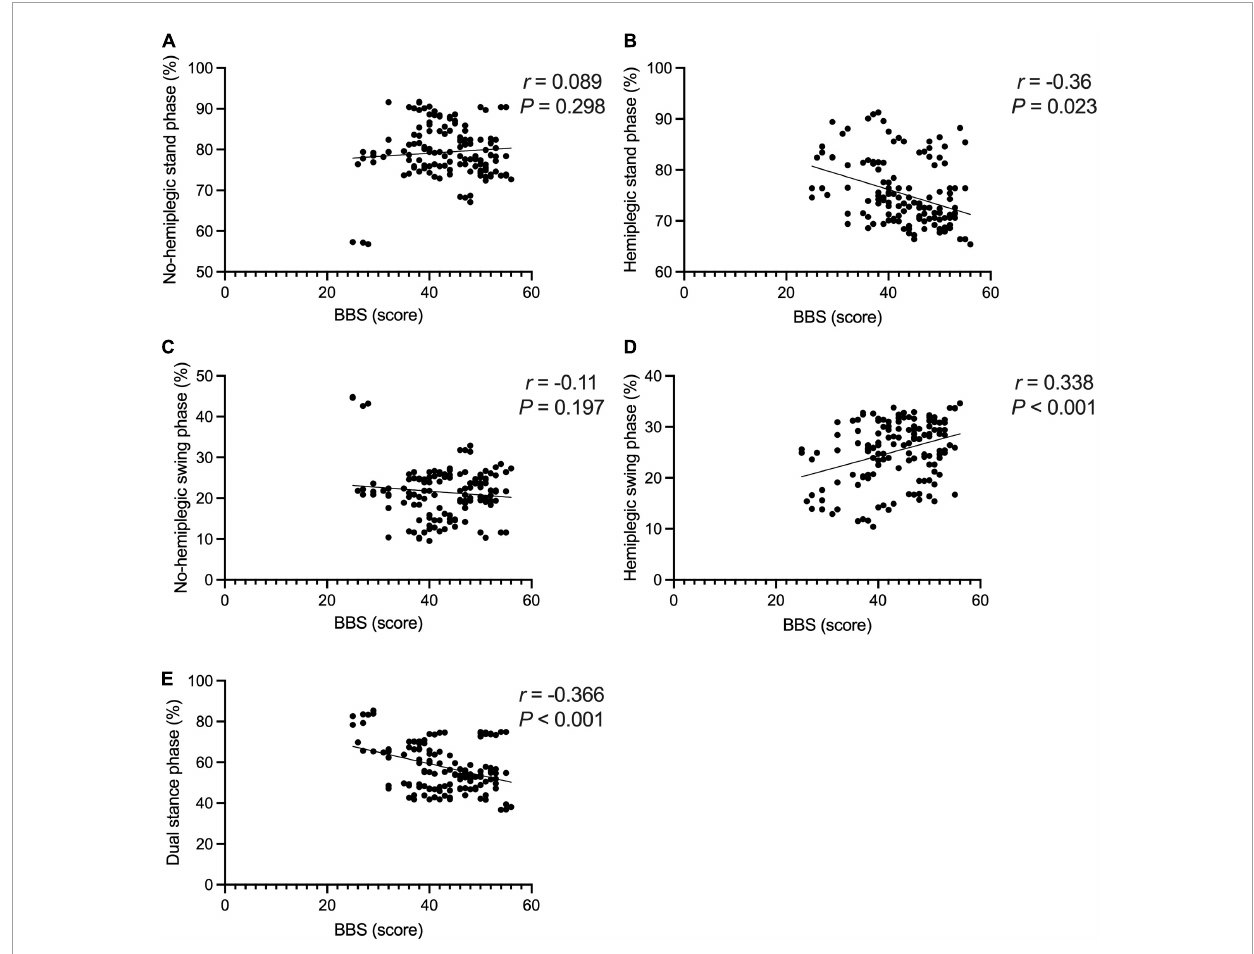
FIGURE9 Correlations between the Berg Balance Scale score and gait cycle in the study group. The BBS score was not correlated with the non-hemiplegic stand phase (A) ( P > 0.05), non-hemiplegic swing phase (B) ( P > 0.05). The BBS score was negatively correlated with the hemiplegic stand phase (C) ( r = − 0.36, P = 0.023), hemiplegic swing phase (D) ( r = − 0.338, P < 0.001). The BBS score was negatively correlated with dual stand phase (E) ( r = − 0.366, P < 0.001).